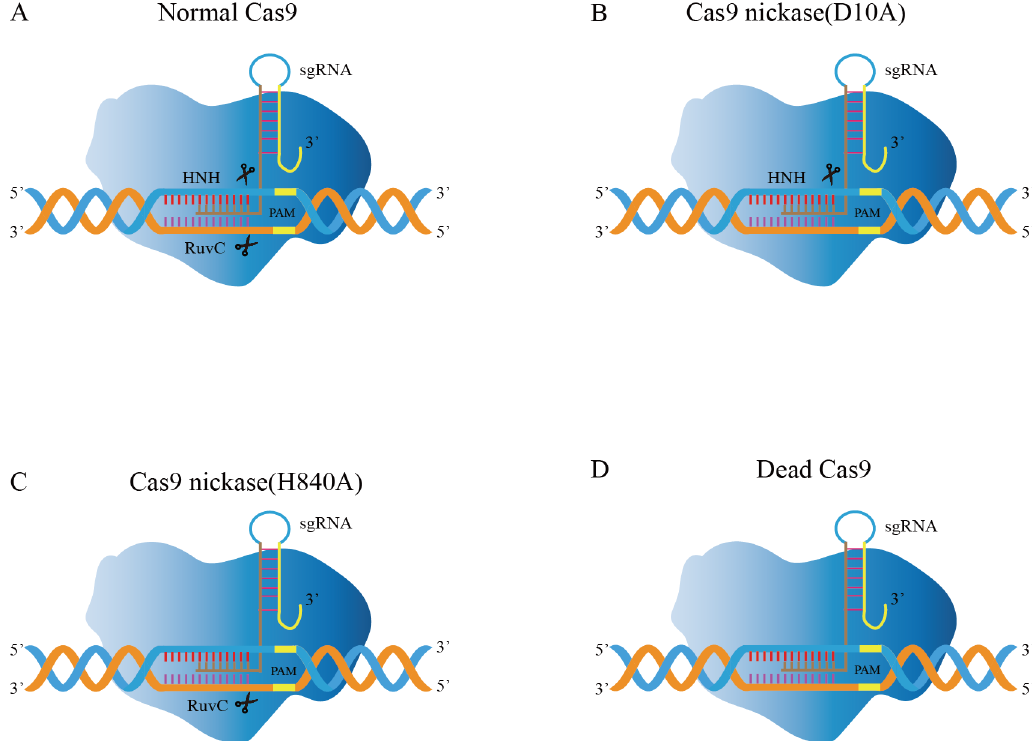
Figure 4. Modifications of Cas9 in genome editing. ( A ) The Cas9 nuclease cleaves the strands of the target DNA via HNH and RuvC domains. ( B ) Cas9n, containing the inactivating mutation D10A, inhibits the activity of the RuvC domain. ( C ) Cas9n, containing the inactivating mutation H840A, inhibits the activity of the RuvC domain. ( D ) Dcas9, inactivating the mutation of HNH and RuvC domains.